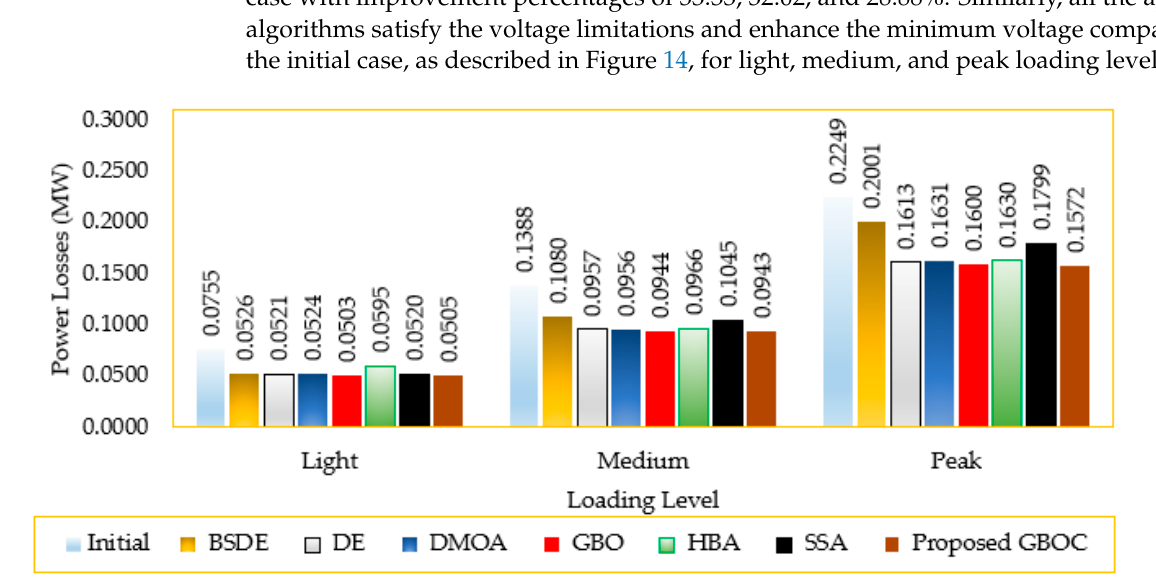
Figure 12. Convergence characteristics of GBOC, GBO, SSA, DMOA, DE, and HBA for the IEEE 69- distribution system for Scenario 1.